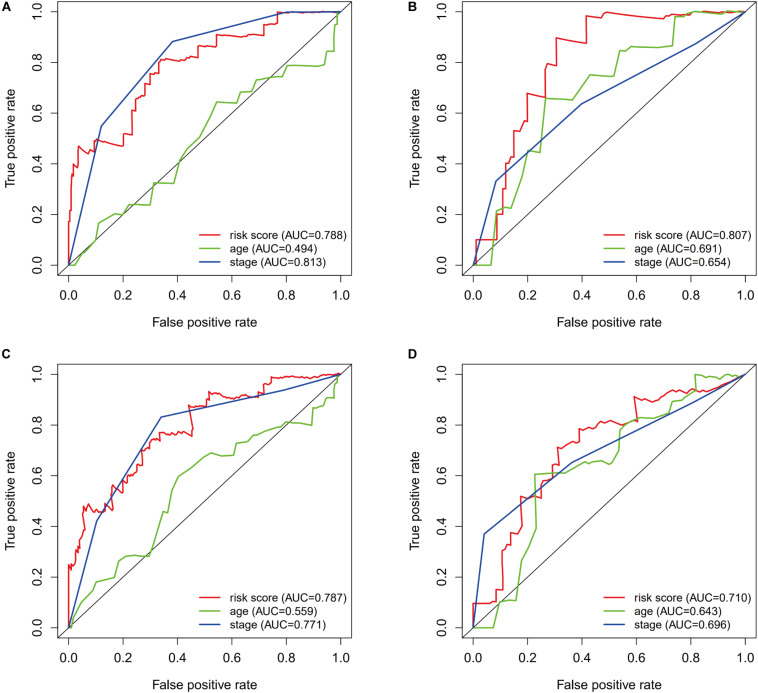
The prognostic value of the immunogenomic risk score. Survival-dependent receiver operating characteristic (ROC) curves for predicting 1-year survival (A) and 3-year survival (C) in the training dataset. The ROC curves for predicting 1-year survival (B) and 3-year survival (D) in the testing dataset.